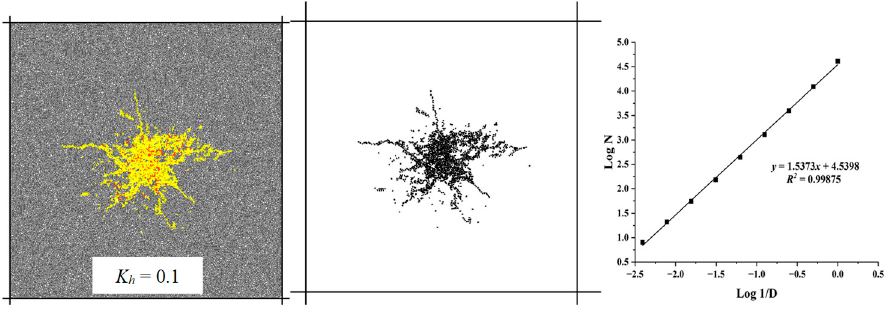
Figure 7. Quantitative evaluation method of fracture network complexity based on fractal dimension.